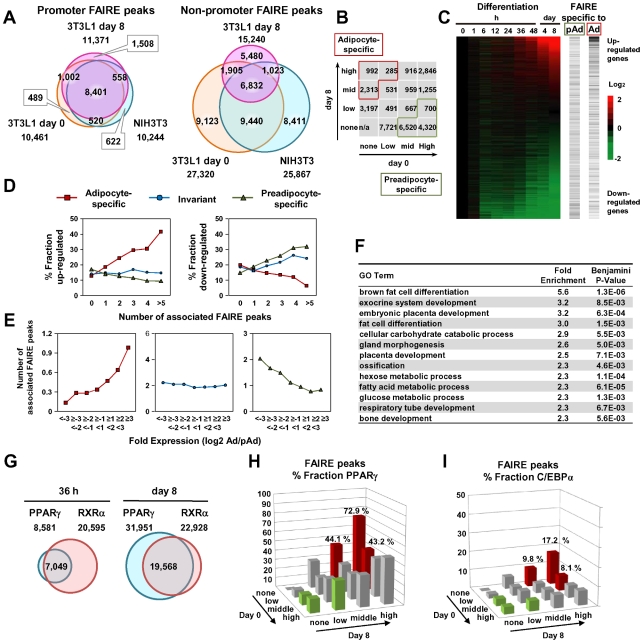
Cell type– and differentiation-dependent FAIRE peaks.(A) Venn diagrams comparing the FAIRE peaks among 3T3-L1 (day 0), 3T3-L1 (day 8) and NIH-3T3 at promoter (+/−500 bp from RefSeq TSS) and non-promoter regions. The promoter FAIRE peaks were relatively constant among the three cell groups while the non-promoter FAIRE peaks were highly variable. (B) The FAIRE peaks in 3T3-L1 (day 0 or day 8) were divided into tertiles by peak height and adipocyte- (red boxes) and preadipocyte-specific (green boxes) FAIRE peaks, and were defined as indicated. (C) A heat map showing enrichment of the adipocyte- and preadipocyte-specific FAIRE peaks in the vicinity (+/−25 kb from TSS) of genes up-regulated or down-regulated during differentiation. The horizontal bars in the two right panels indicate each gene with Ad or pAd FAIRE peaks in the vicinity (+/−25 kb from TSS). (D) Fractions of genes that were up-regulated (left) or down-regulated (right) more than two-fold during differentiation among genes that had the indicated number of adipocyte- (red), preadipocyte-specific (green) or invariant (blue) FAIRE peaks. (E) The number of the adipocyte- (red), preadipocyte-specific (green) or invariant (blue) FAIRE peaks associated with genes that were stratified by the ratio of the expression levels between preadipocytes and adipocytes. Each FAIRE peak was defined as associated with the nearest gene in analyses (D) and (E). (F) Ontology analysis by DAVID of genes associated (+/−25 kb from TSS) with adipocyte-specific FAIRE peaks [13]. (G) Venn diagrams showing the numbers and overlap of the binding sites for PPARγ and RXRα in 3T3-L1, day 0 and day 8. (H, I) Fractions of the non-promoter FAIRE peaks that overlap PPARγ binding sites (day 8) (H) or C/EBPα binding sites (Schmidt et al., GSE27450 [86]) (I). PPARγ and C/EBPα represented 45.3% and 11.7% of the adipocyte-specific FAIRE peaks (average of red bars).